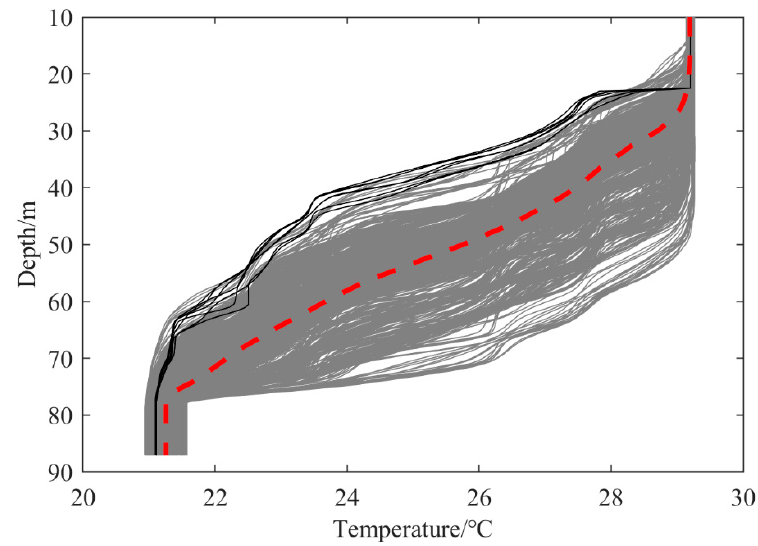
Figure 14. Temperature profiles in the training set and some temperature profiles with large errors in the test set.